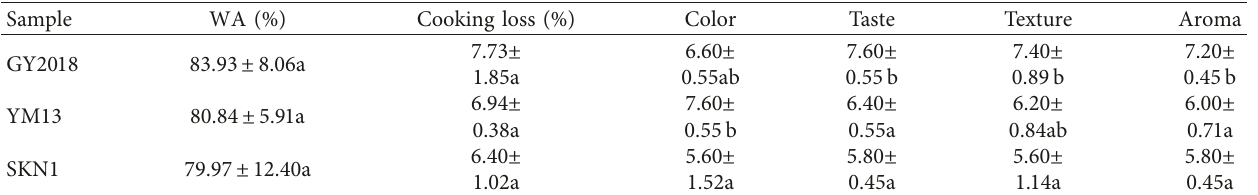
Table 1: Noodle properties of GY2018, YM13, and SKN1.